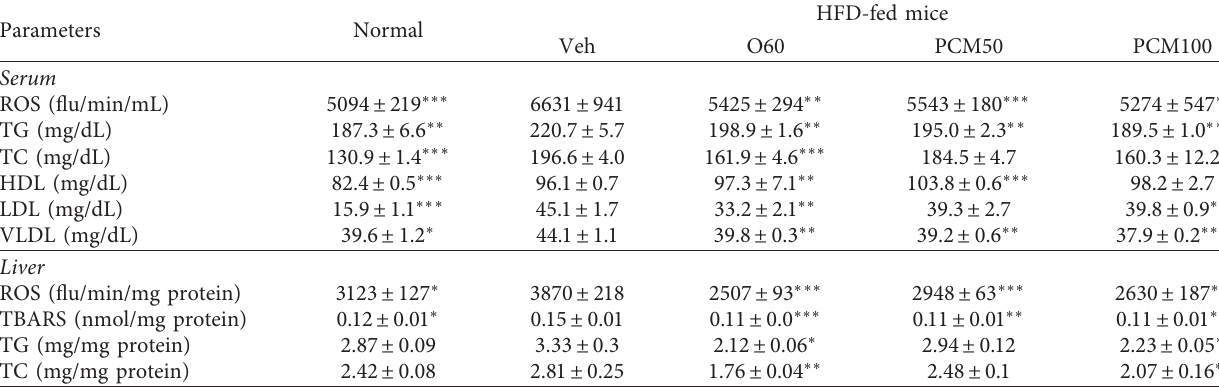
Table 2: Biochemical analyses.